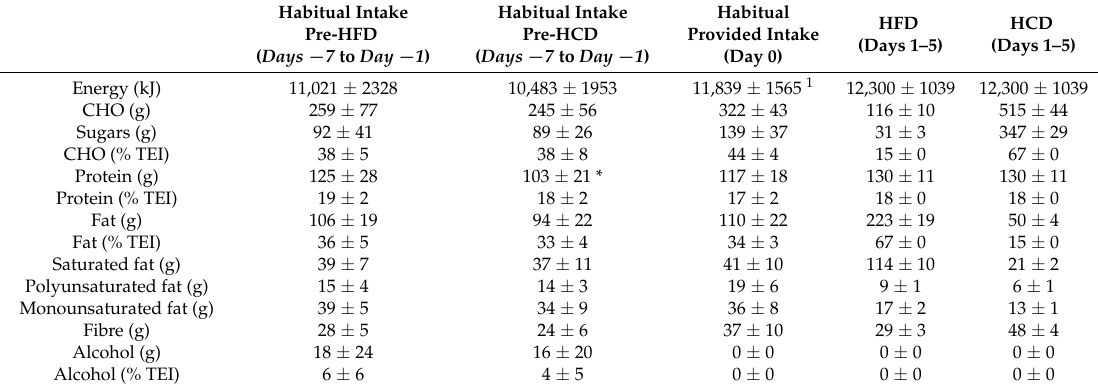
Table 1. Dietary intake breakdown of provided (habitual: Day 0 ; experimental: Days 1–5 ) and habitually consumed (habitual: Day − 7 to Day − 1 ) diets for overweight, sedentary males ( n = 7).